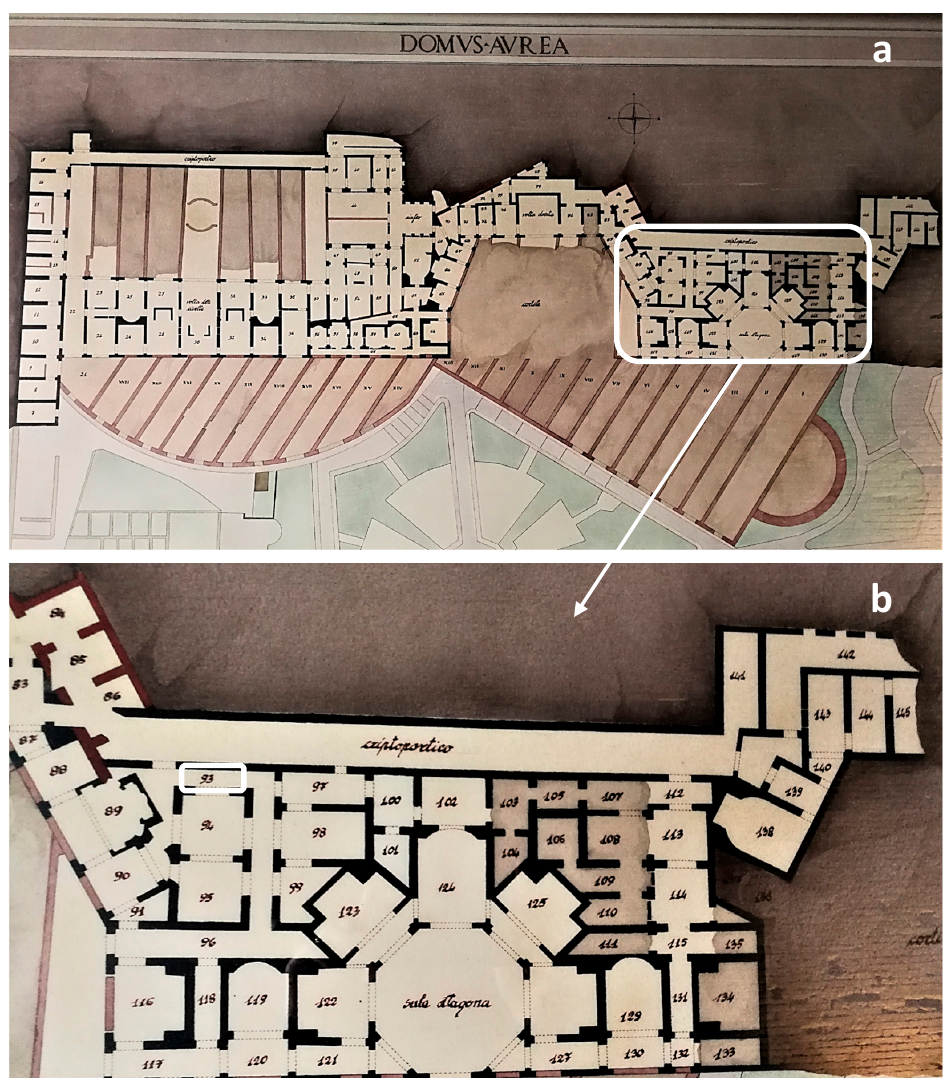
Figure 1. ( a ) Map of the remains of the Domus Aurea which consists of a series of buildings separated by gardens, woods and vineyards; ( b ) a detail of the area where the study site, Room 93, is located.